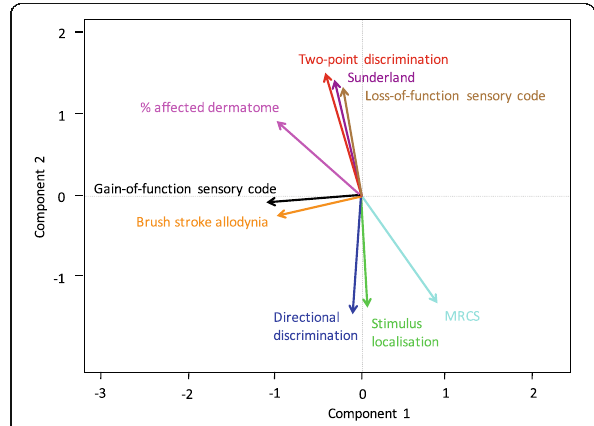
Fig. 2 Biplot of objective neurosensory measurements. An acute angle indicates a positive correlation. A 90-degree angle indicates no correlation between the two variables, and an obtuse angle indicates a negative correlation. The more similar the direction of two vectors, the stronger the correlation between these